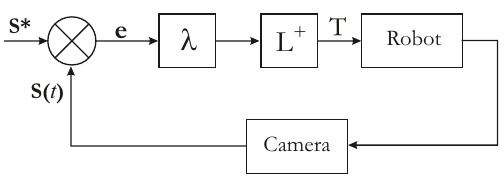
Figure 6. Classical visual servoing